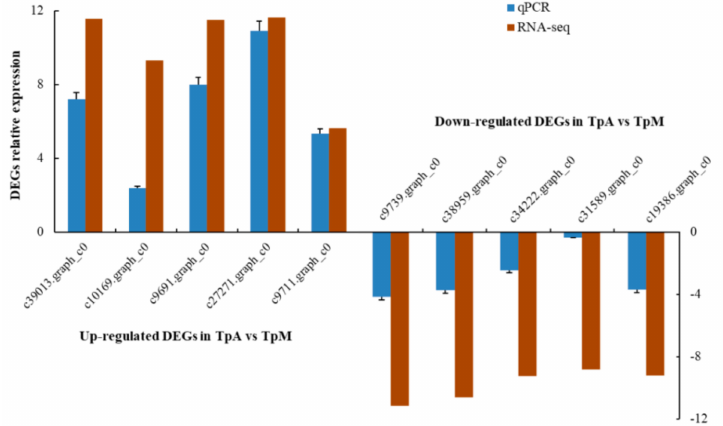
Figure 6. Validation of 10 selected DEGs derived from RNA-seq using quantitative PCR: Tp-actin gene was used as a reference gene. The error bars represent the standard deviation for three biological